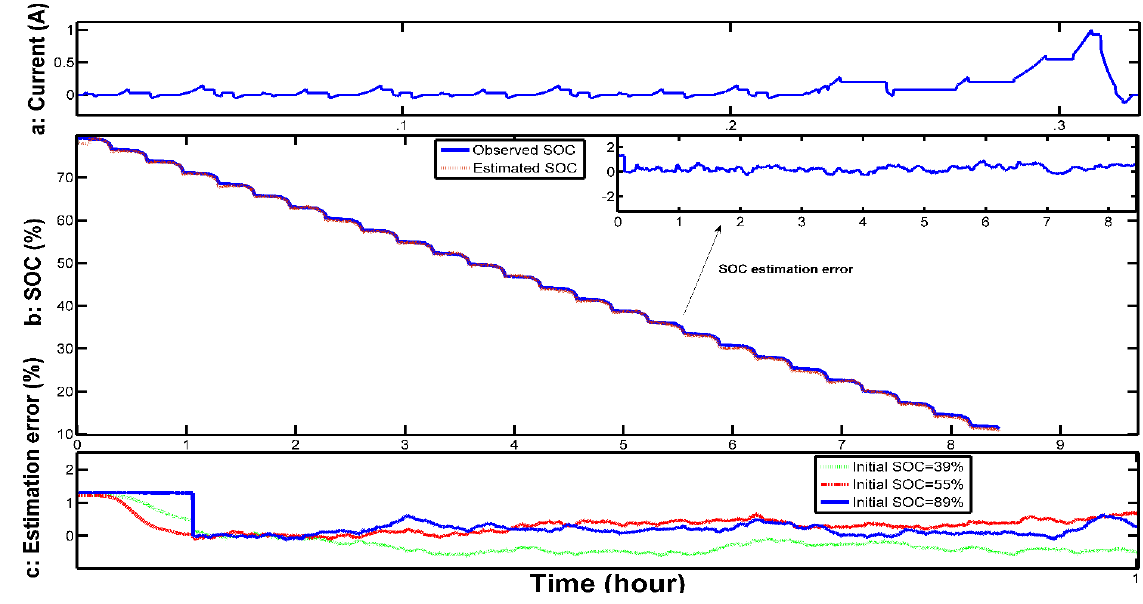
Figure 10. ( a ) Normalized NEDC current profile; ( b ) Observed SOC and estimated SOC for the pack by proposed method; ( c ) SOC estimation error for different initial